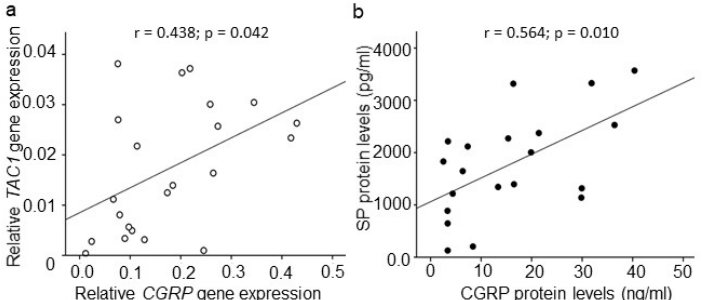
Figure 4. Correlations among CGRP and SP expression in DDD patients. ( a ) Correlation among TAC1 and CGRP gene expression ( r = 0.438; p = 0.042; n = 22; Spearman correlation co-efficient) and, ( b ) Correlation among CGRP and SP ( r = 0.564; p = 0.010; n = 20; Spearman correlation co-efficient) in IVD tissues.